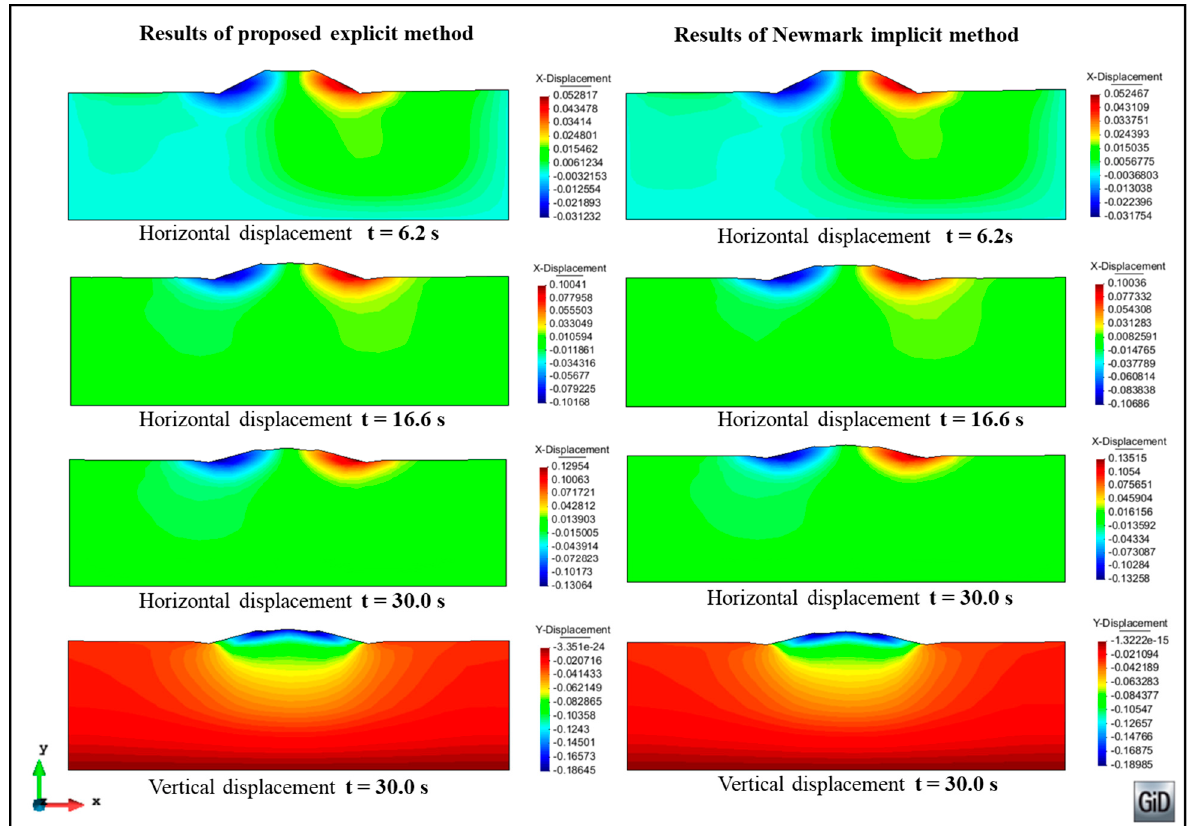
Figure 12. Contour plots of horizontal and vertical displacements of the model. Figure 13 shows the contour plots of pore pressure ratios of the ground soil. The loose sand layer near the drainage boundary liquefies at 6.2 s and 16.6 s. As the decrease in the input acceleration, the pore water is drained upwards, and the soil particles are redistributed. The soil tends to a stable